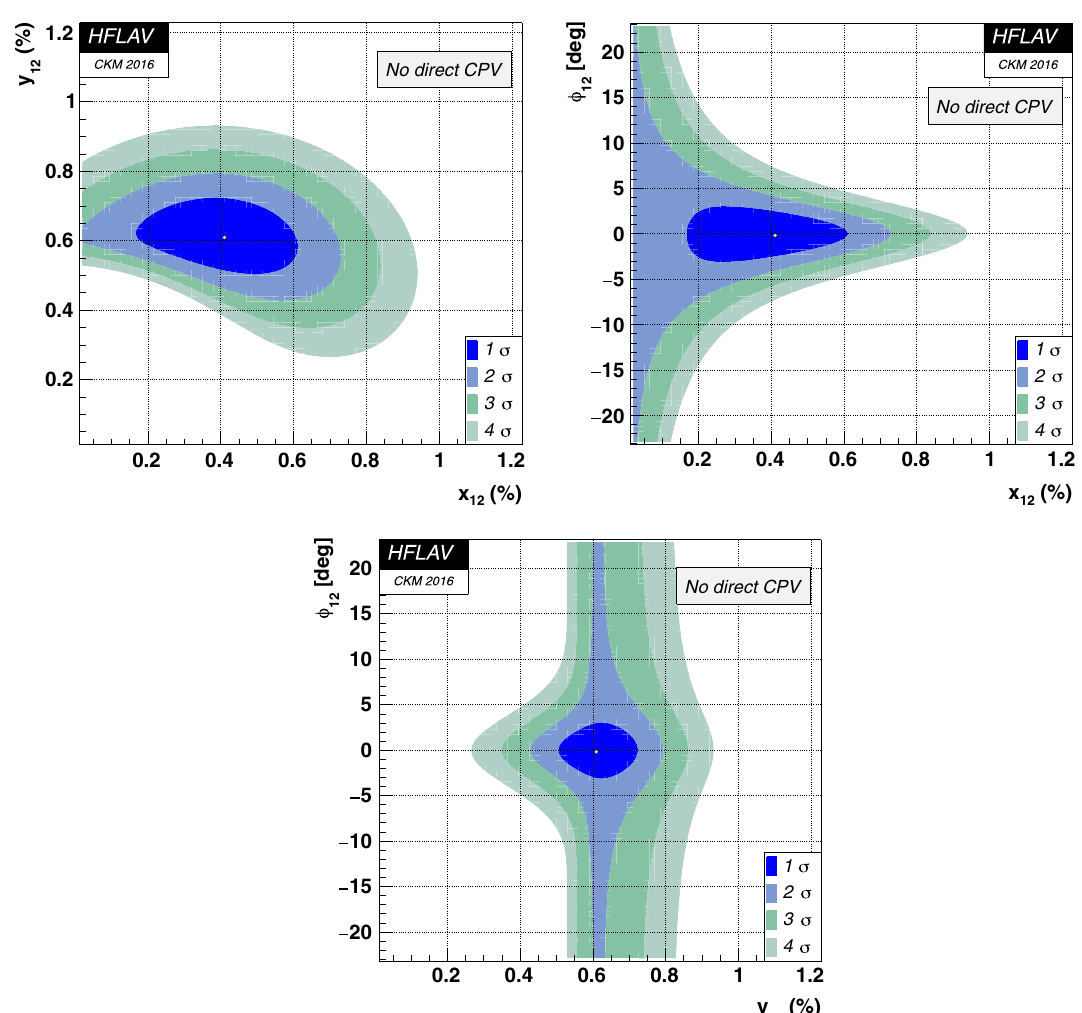
, y ) ( top left ), ( x ,φ ) ( top right ), and ( y 12 12 12 12